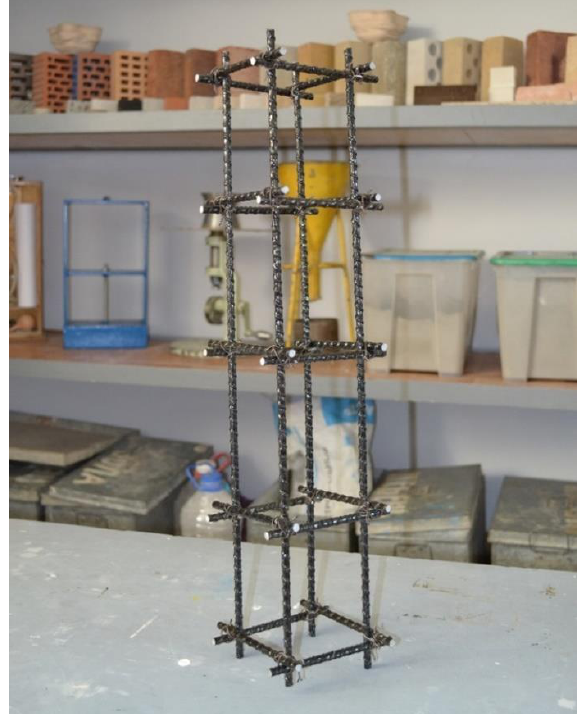
Figure 2. Photo of a frame made of polymer composite reinforcement.